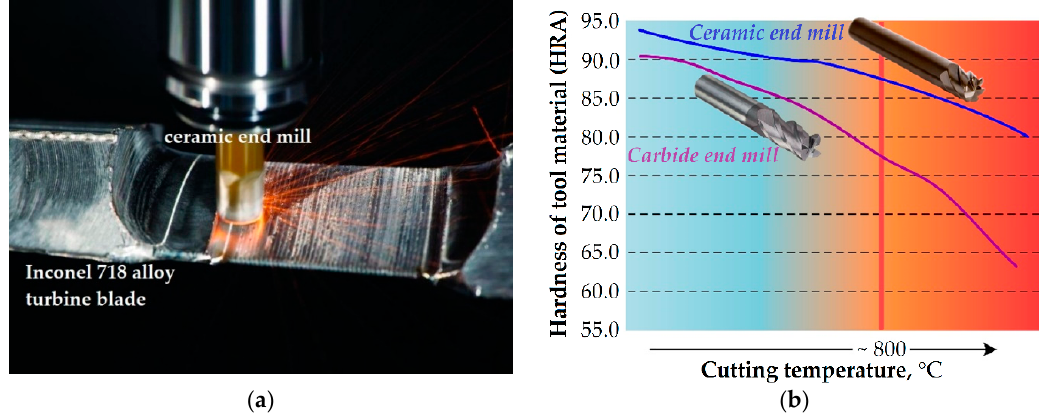
Figure 1. An example of industrial use of SiAlON solid ceramic mills in high-speed milling of a nickel alloy turbine blade ( a ) and the variation in surface hardness of end mills produced from ceramics and hard alloy ( b ) as a function of the cutting temperature.